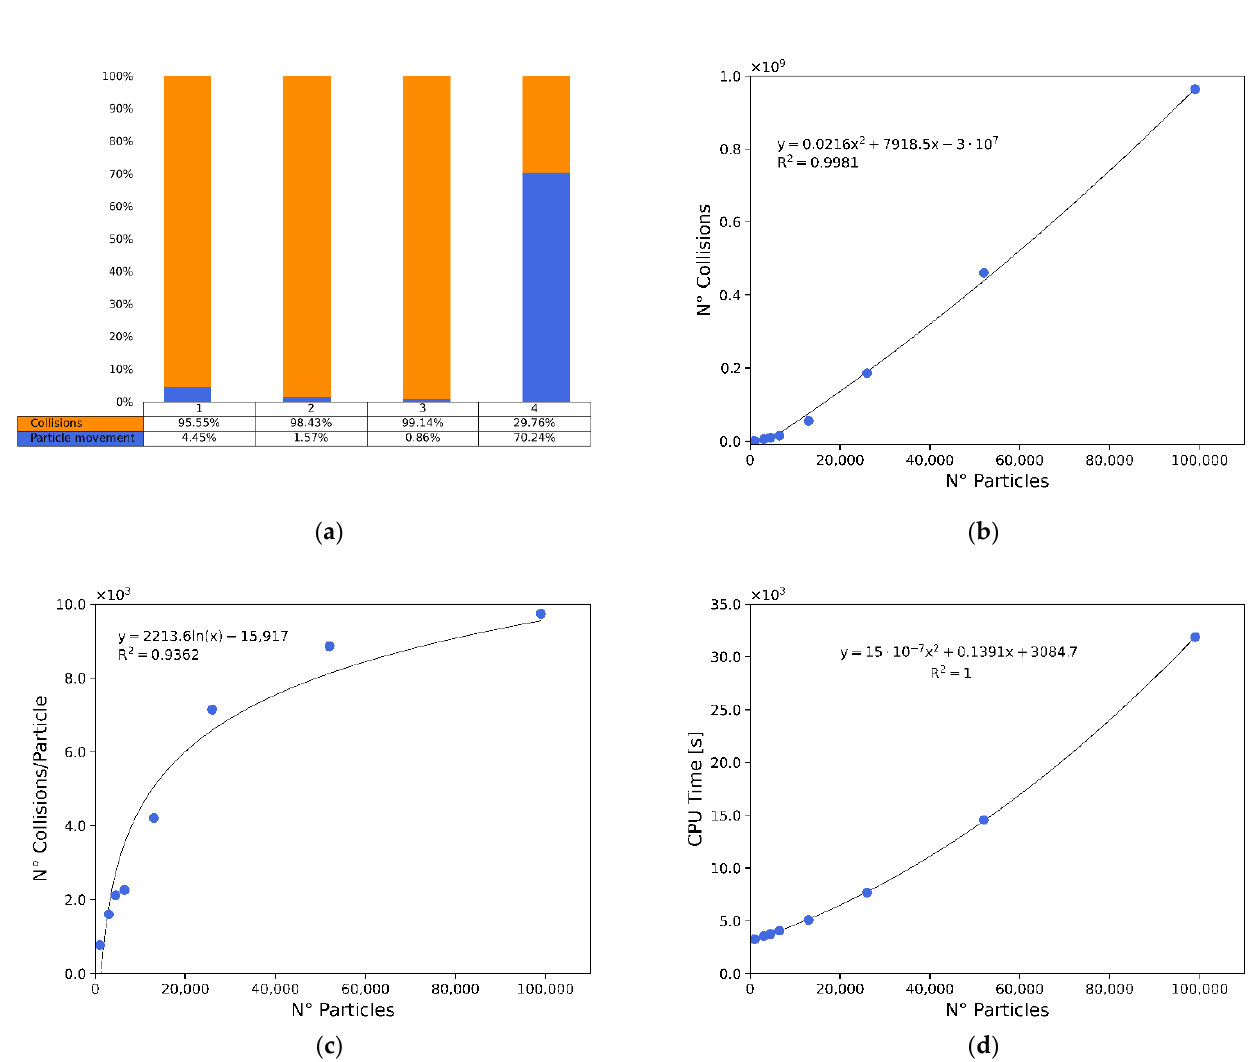
Figure 7. Computational time devoted to the simulation. ( a ) Comparison of computational time used calculating particle collisions (orange) and particle movement (blue), for 4 cases: 1000 (1), 3000 (2), 6500 (3), and 500 (4) particles, respectively, where in case 4 no interparticle collisions are allowed by the model; ( b ) number of interparticle collisions versus number of particles simulated; ( c ) number of interparticle collisions normalized by number of particles simulated; and ( d ) CPU time (in seconds) devoted to each multiparticle simulation.